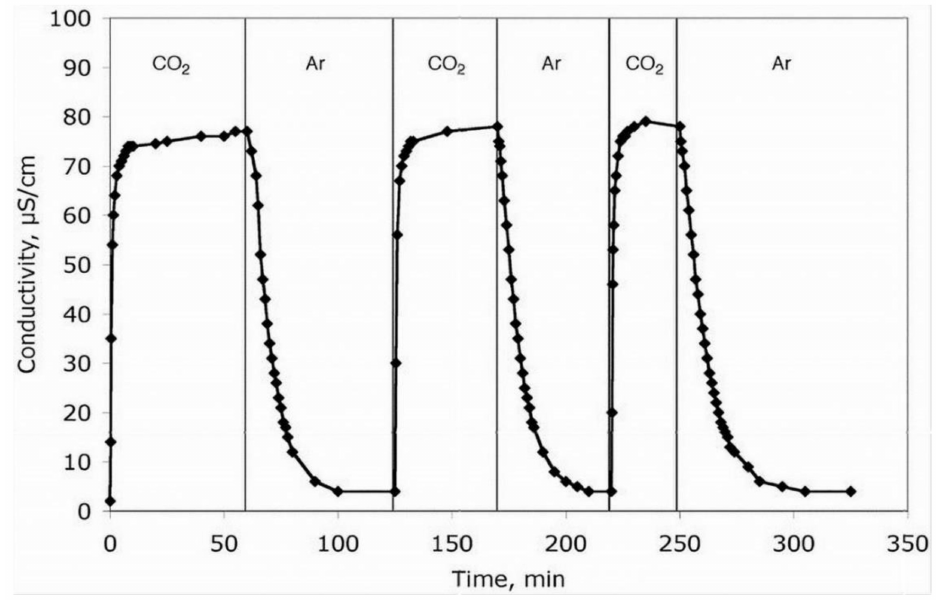
Figure 8. The conductivity of a Dimethyl sulfoxide (DMSO) solution as a time-dependent throughout 3 phases of CO 2 treatment followed by argon at 23 ◦ C